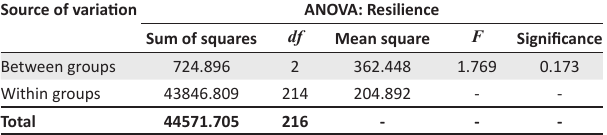
TABLE 3: Analysis of variance resilience across different contexts.